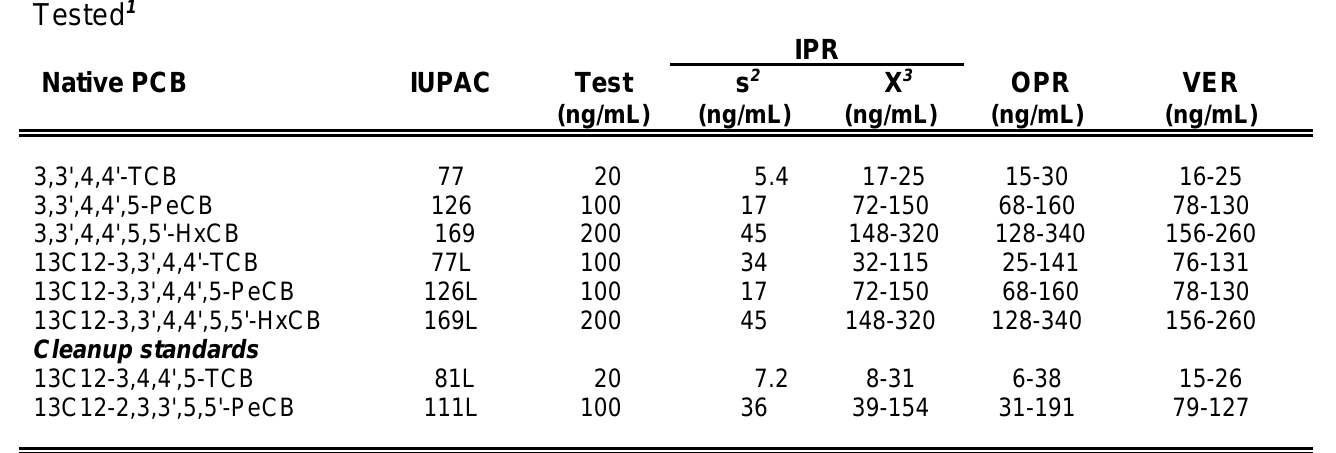
Table 6a. Preliminary Acceptance Criteria for Performance Tests when PCBs 77, 126, and 169 only